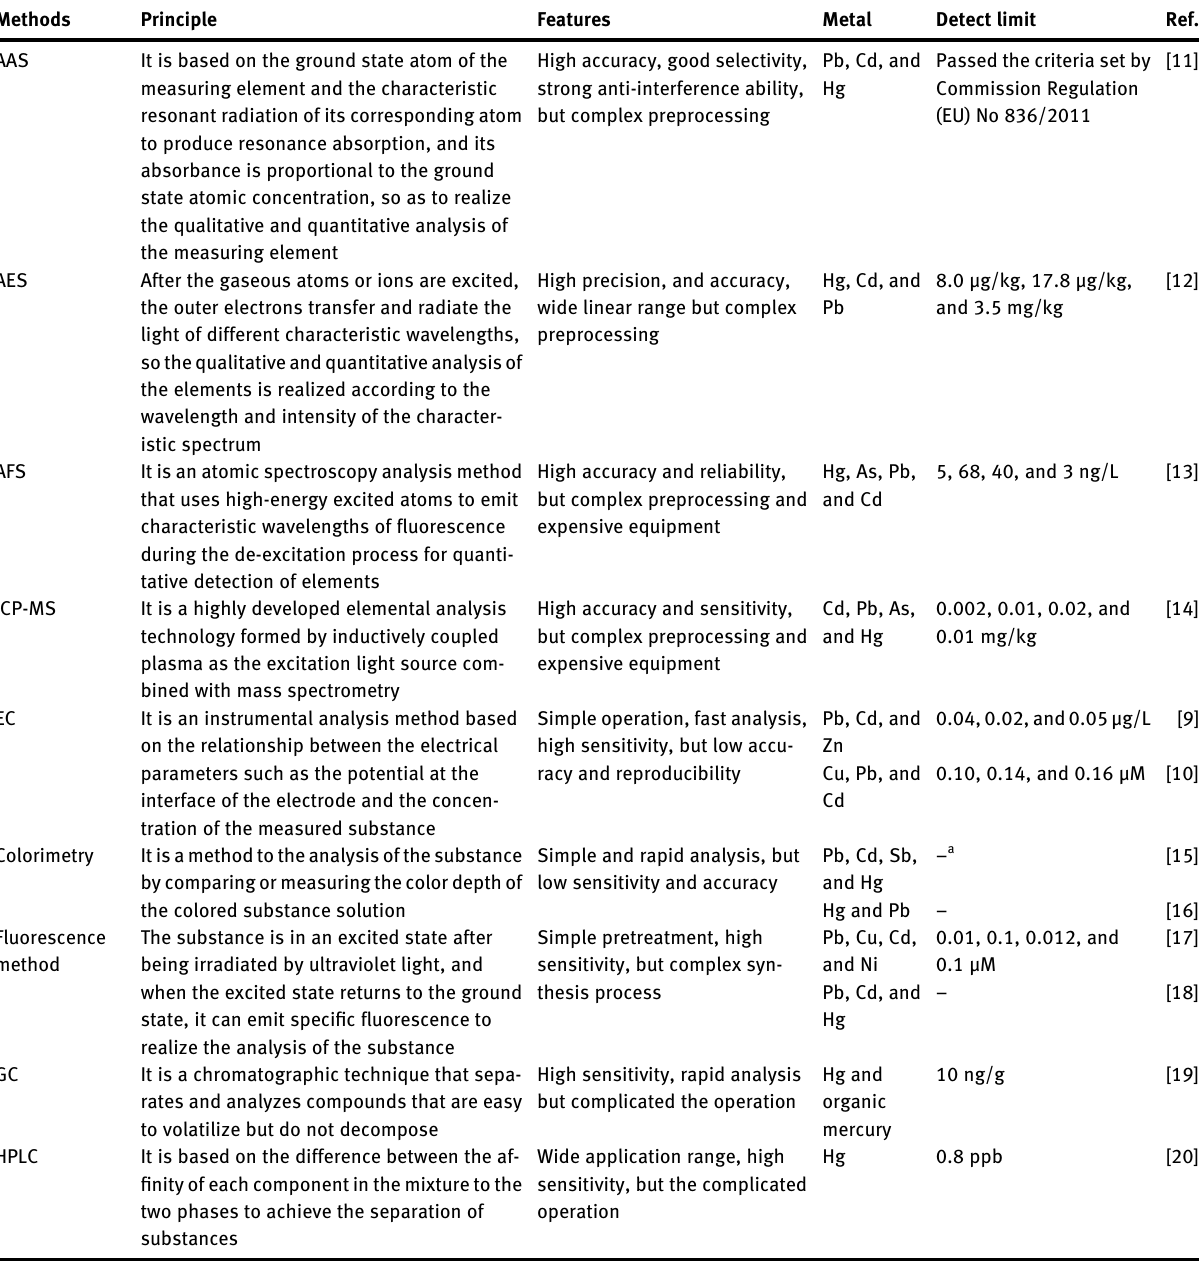
Table  : Several different methods to detect heavy metals.